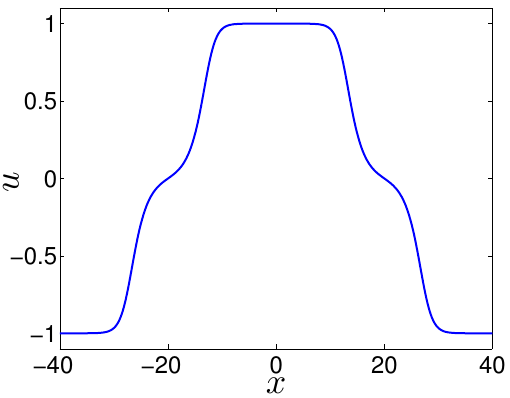
Figure 4 . An example of (stationary) kink-antikink configuration with ǫ = 0 . 05 and x 0 = 20. v 2 , x 0 is where the kink is initially centered such that 2 x 0 is the initial where γ := 1 / √ 1 − separation between the kink and antikink, and v is the velocity of the moving kink. (The velocity of the moving antikink is v .) Then, the initial conditions for our simulations are − given